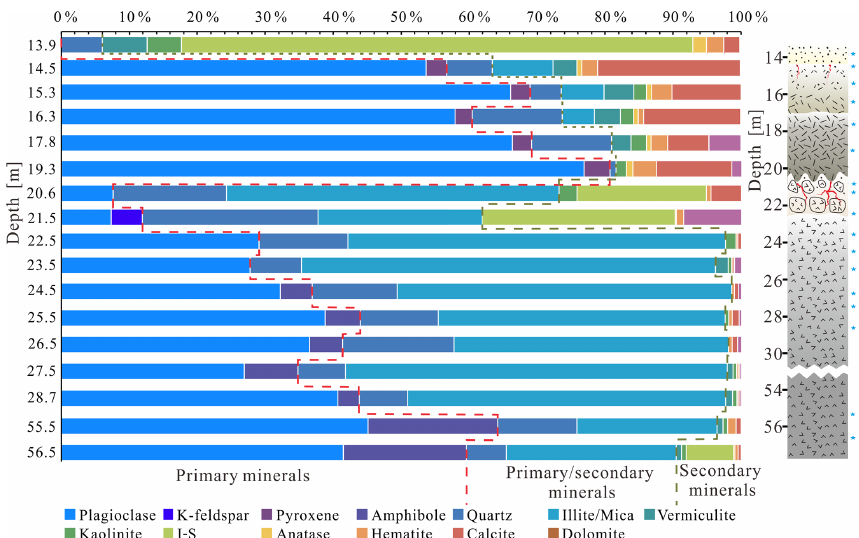
Figure 3. Mineral compositions of both Permian volcanic lava and Paleozoic basement rock in the GA1 drill core (measured by powder XRD).